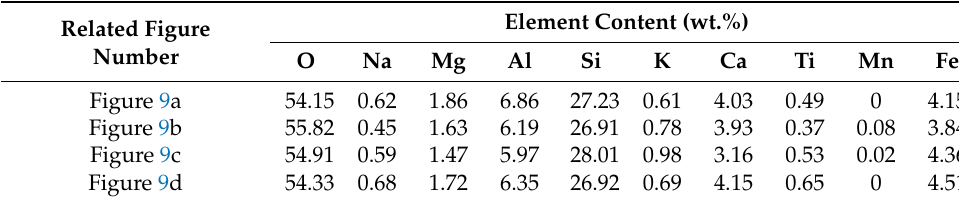
Table 3. EDX analysis results of sample